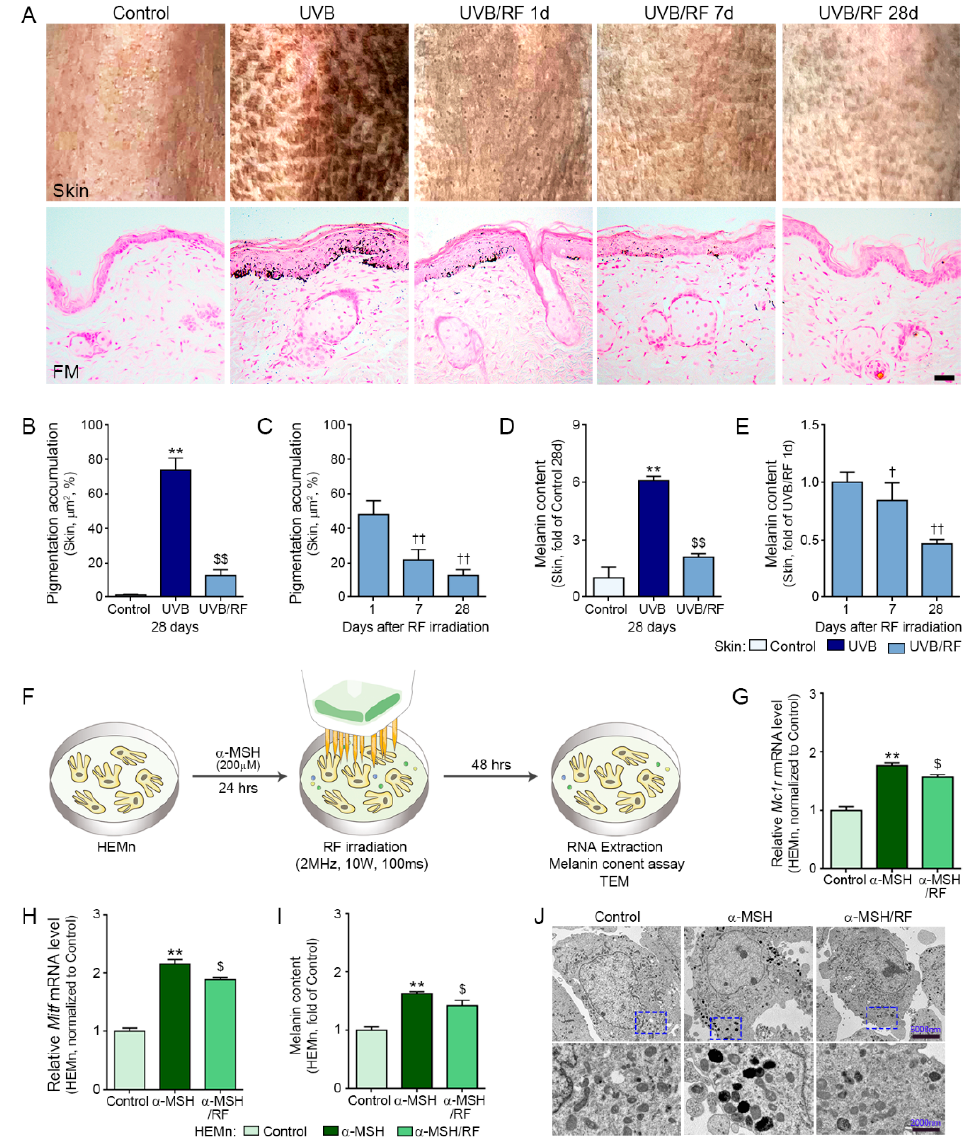
Figure 4. Reduction in melanin accumulation via autophagy activation by RF irradiation. ( A ) Pigmentation changes in UV-B-exposed mouse skin were assessed 1, 7, and 28 days after RF irradiation (upper row). Melanin content was assessed by FM staining (lower row; scale bar = 100 µm); ( B , C ) Quantitative graphs of representative mouse skin images and ( D , E ) representative FM staining images; ( F ) HEMn were treated either with α -MSH (200 µM) or with α -MSH/RF (2 MHz, 10 W for 100 ms) in vitro, or otherwise not irradiated (control); ( G , H ) The mRNA expression levels of MC1R ( F ), and MITF ( G ) were identified in the skin tissue. All mRNA levels were measured by qRT-PCR, normalized versus ACTB, and expressed relative to levels in the control; ( I ) Melanin content was measured in HEMn after RF irradiation; ( J ) Changes in melanin after RF irradiation were observed with TEM. Data are presented as mean ± SD. **, p < 0.01, vs. control 28 days (skin) or control (HEMn); $, p < 0.05; $$, p < 0.01, vs. UV-B 28 days (Skin) or α -MSH (HEMn); †, p < 0.05; ††, p < 0.01, vs. 1 day after RF irradiation (Mann–Whitney U test). α -MSH, alpha-melanotropin; FM, Fontana-Masson staining; HEMn, human epidermal melanocyte; NF- κ B, nuclear factor kappa-light-chain-enhancer of activated B cells; MC1R, melanocortin 1 receptor; MITF, micropthalmia-associated transcription factor; RF, radiofrequency; TEM, transmission electron microscopy; TNFR, tumor necrosis factor receptor; TLR4, Toll-like receptor 4; UV-B, ultraviolet-B; UV-B/RF, UV-B plus RF.